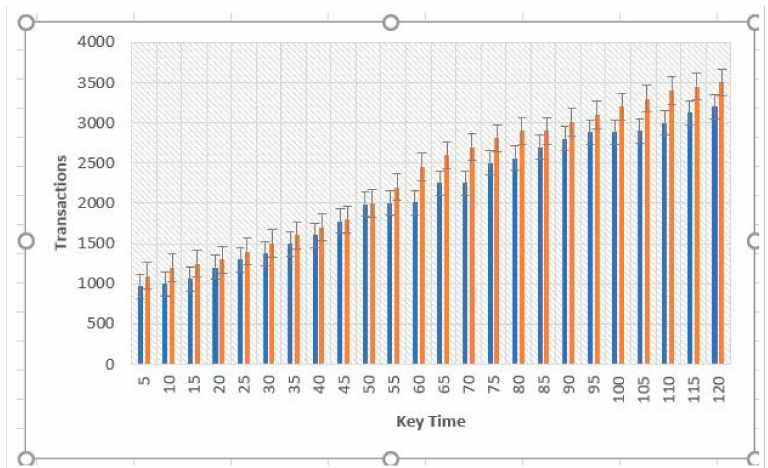
Figure 4. Comparison of time cost values within the same networks. The orange bars show hashgraph transactions, and the blue bars show the blockchain transactions.